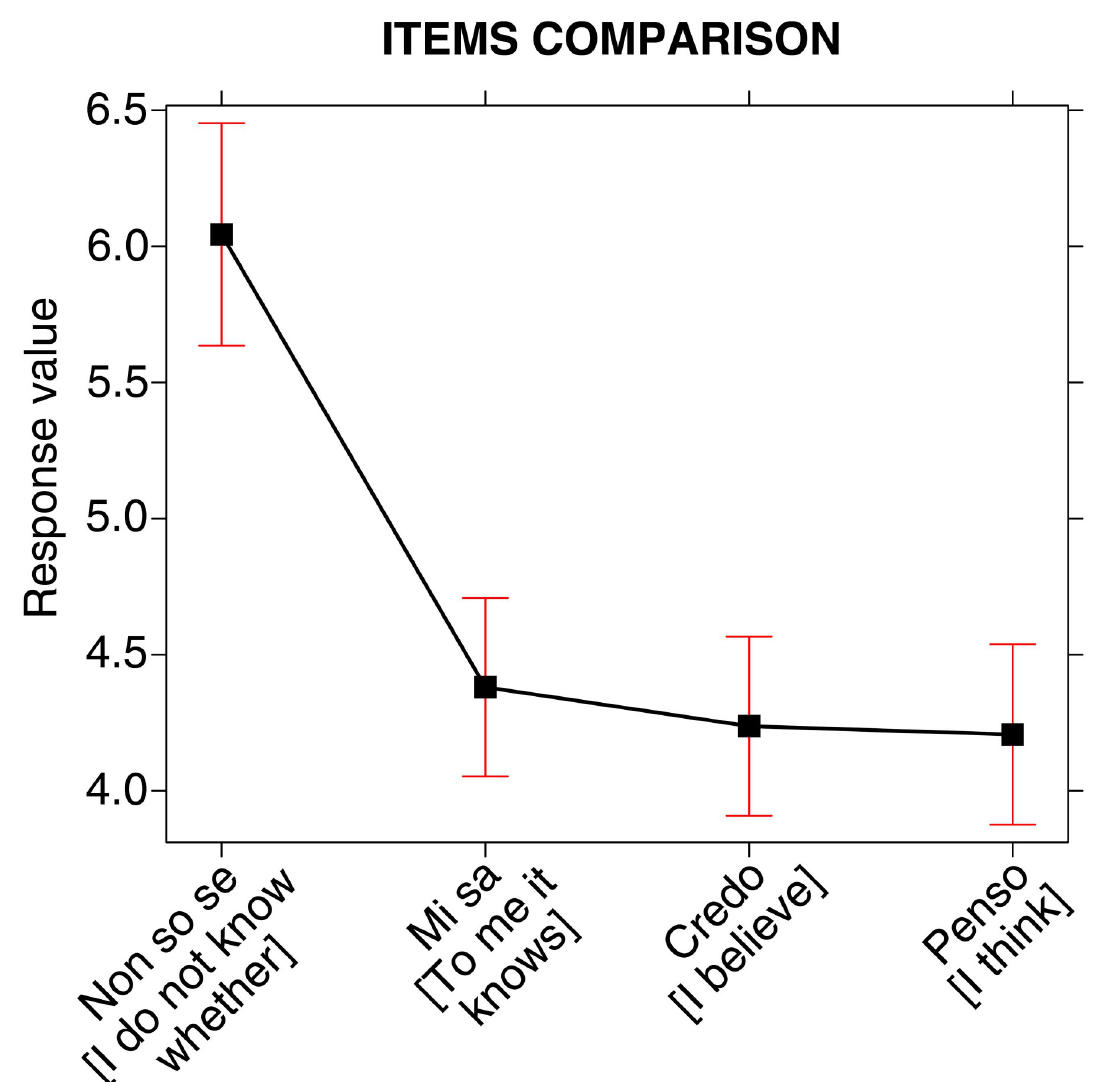
Fig 7. Distribution of the four sentences for degrees of